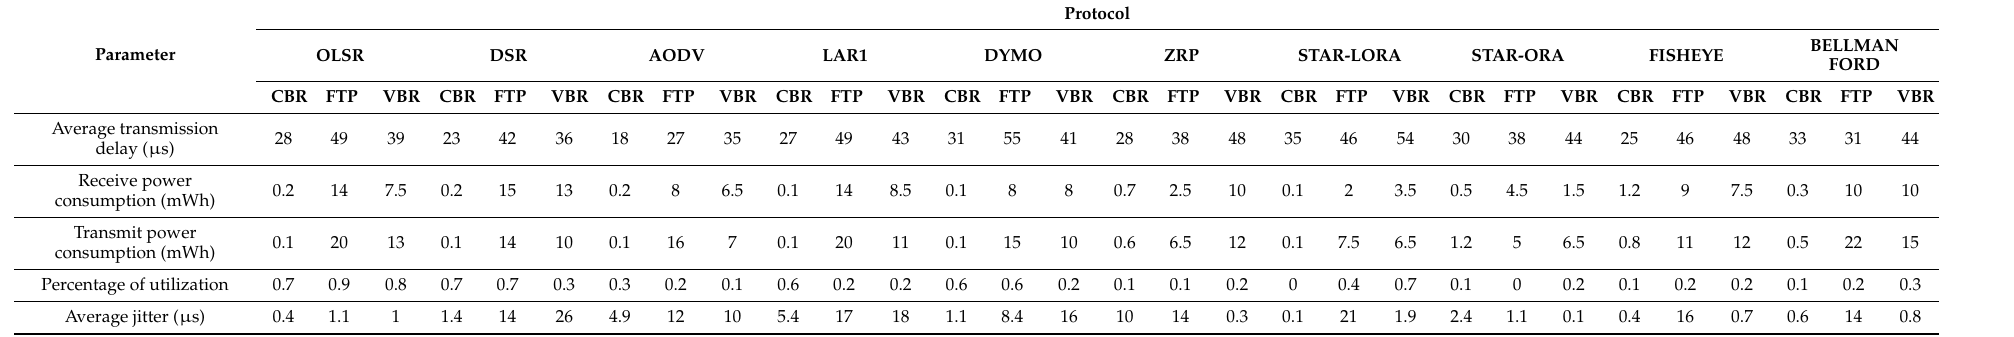
Table 1. Comparison of all routing protocols for 60 nodes.